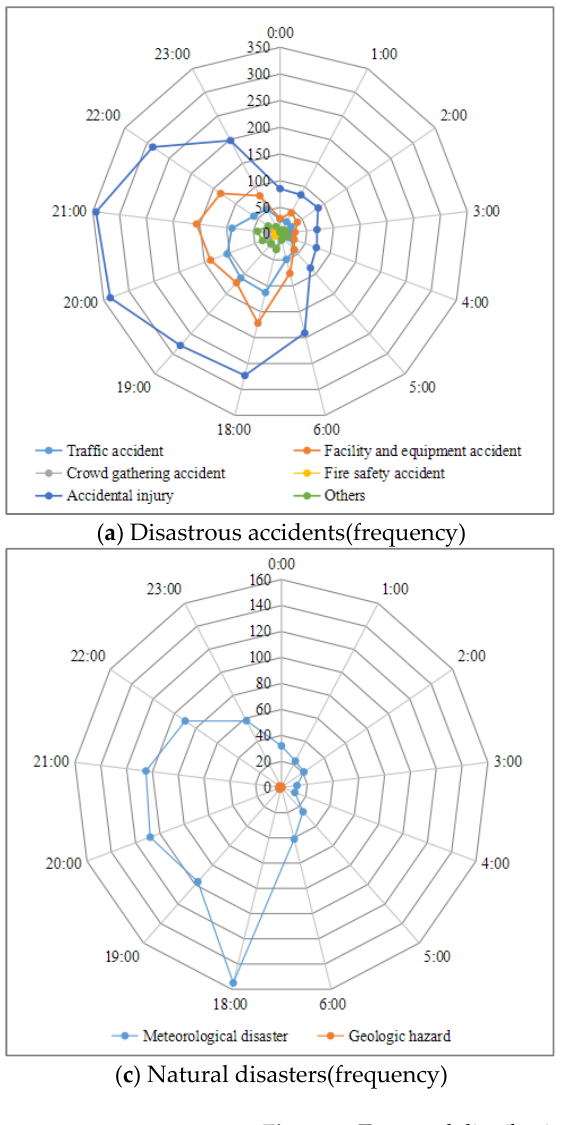
Figure 2. Temporal distribution of night tourism accidents.